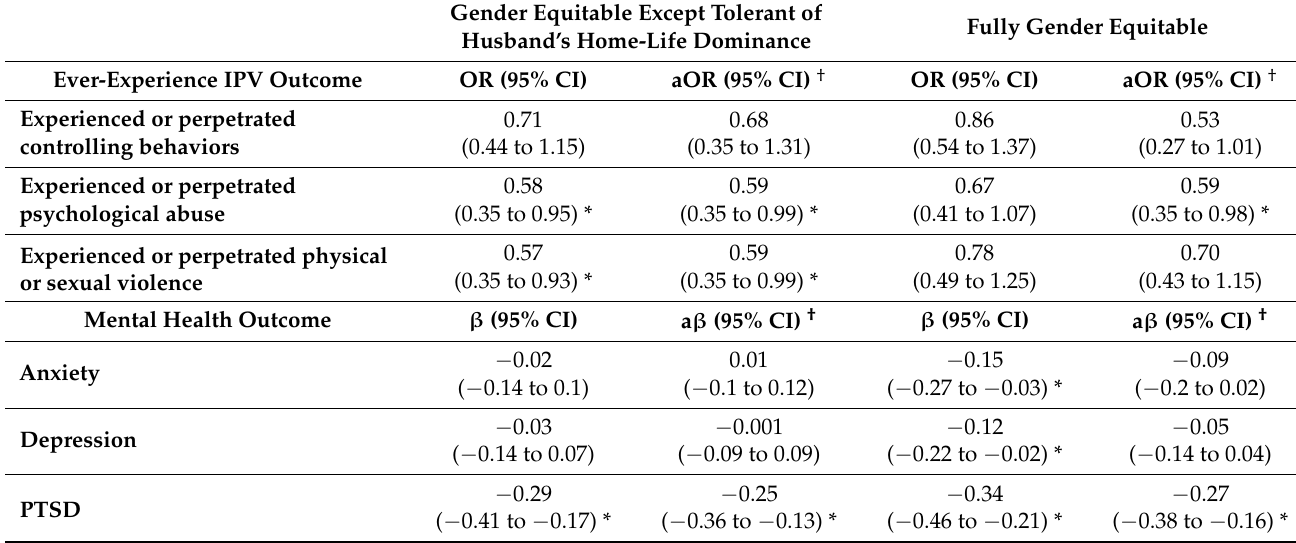
Table 5. Unadjusted and adjusted odds ratios ( n = 772) and linear regressions ( n = 784) with Tolerant of IPV as the reference